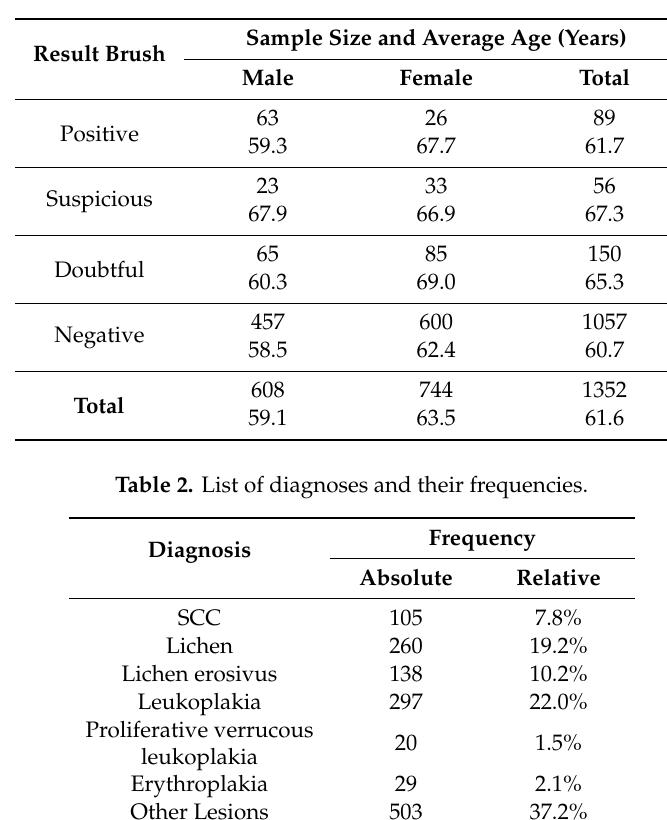
Table 1. Total numbers of sample size and average age (years).